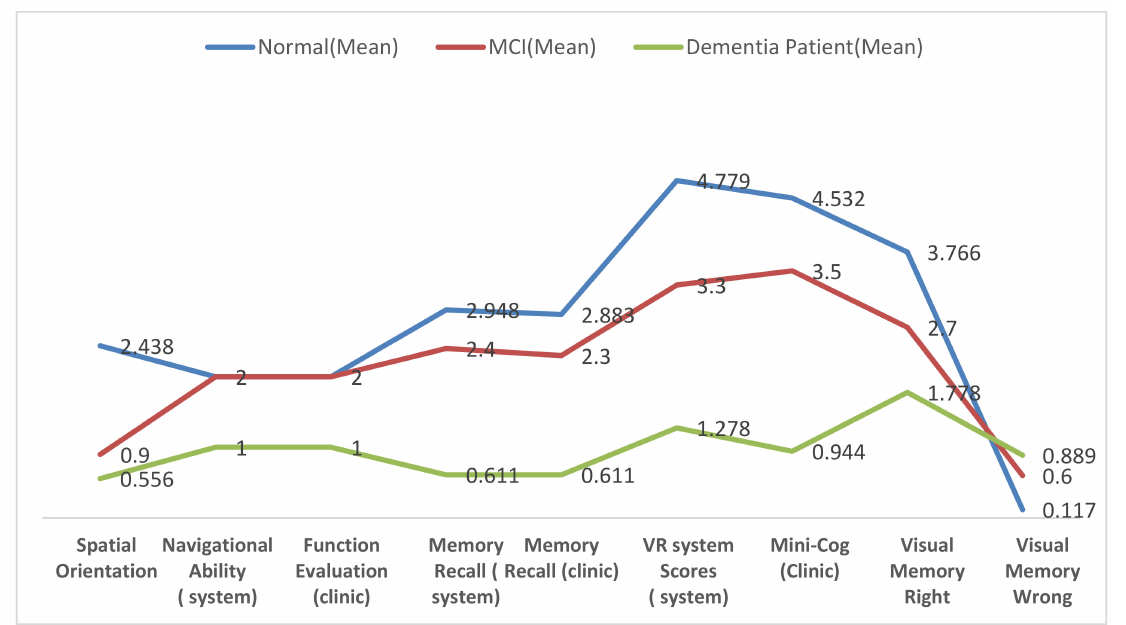
Figure 7. Means of cognitive test and neuropsychological abilities.